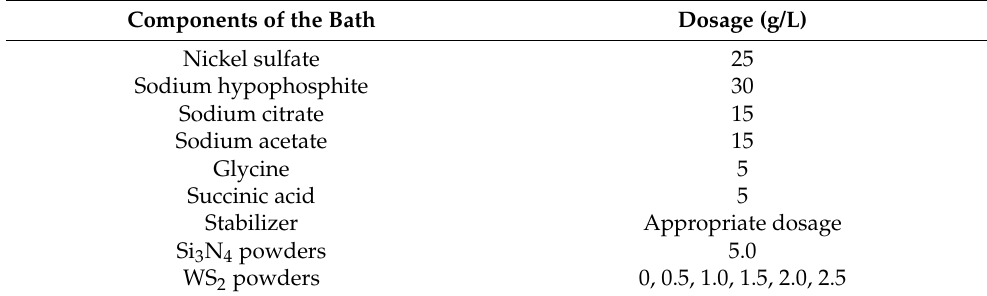
Table 1. Components of the electroless plating bath.